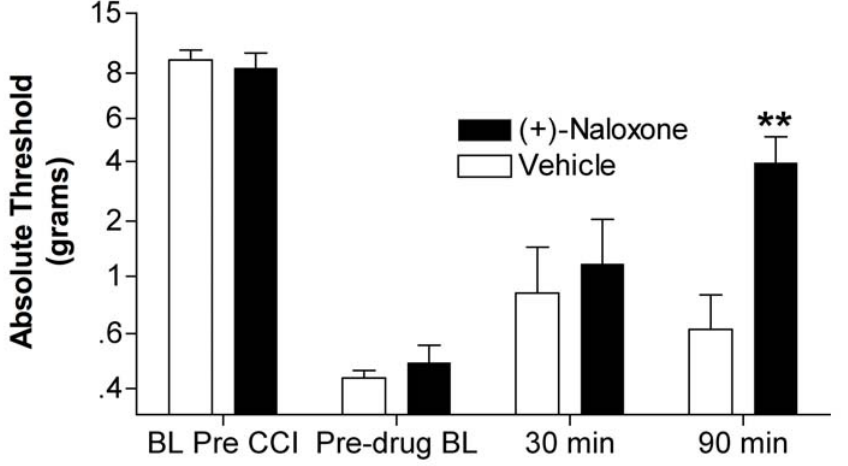
FIGURE 4. Systemic (+)-naloxone acutely reverses CCI-induced allodynia. (+)-Naloxone (60 mg/kg s.c., kindly supplied by NIDA drug repository) reversed established allodynia 90 min, but not 30 min, following drug administration (n = 5 per group). BL pre-CCI Von Frey testing of thresholds occurred the day of CCI surgery of the left sciatic nerve. Allodynia developed across the following 10 days with maximal allodynia achieved and maintained from this point for a further 21 days. Predrug BL thresholds were assessed the morning of the test day. All Von Frey testing was conducted blinded to treatment group by two separate experimenters 30 and 90 min postdrug